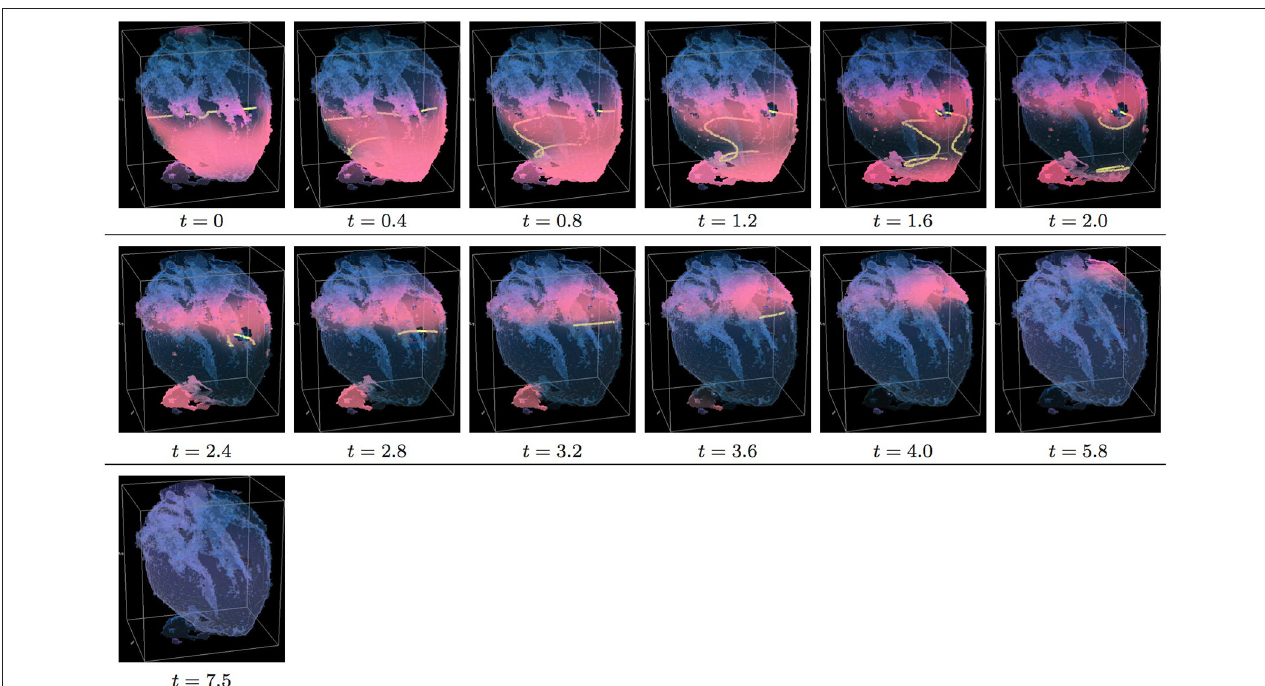
FIGURE 5 | Isotropic whole heart simulation. The translucent fetal heart is shown in blue, excitation front shown in red (see the color box in Figure 3 ), the yellow lines are the instant organizing filaments of the excitation vortices; time shown under each panel in time units of Equations (1, 2). After a short transient the organizing filament of the initial vortex breaks into the two pieces each of which fast terminates: one at the base and another at the apex of the heart (See Supplementary Video 5 ).